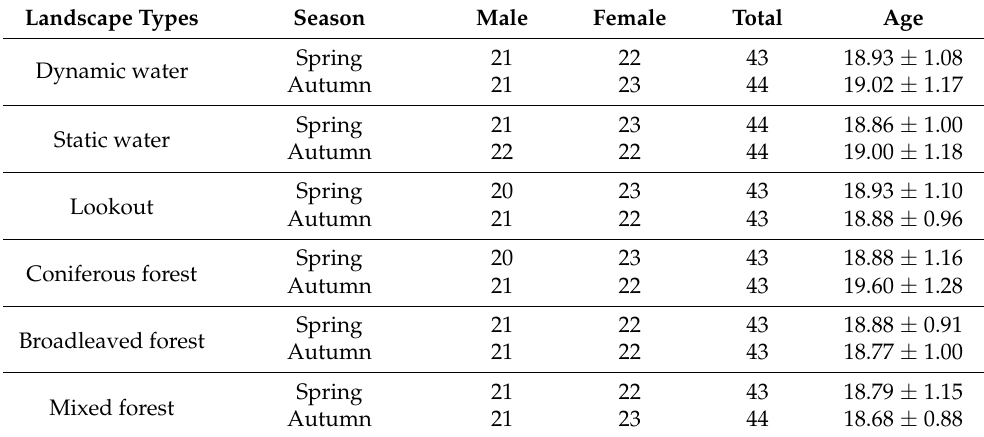
Table 3. Demographics of the participants ( n =